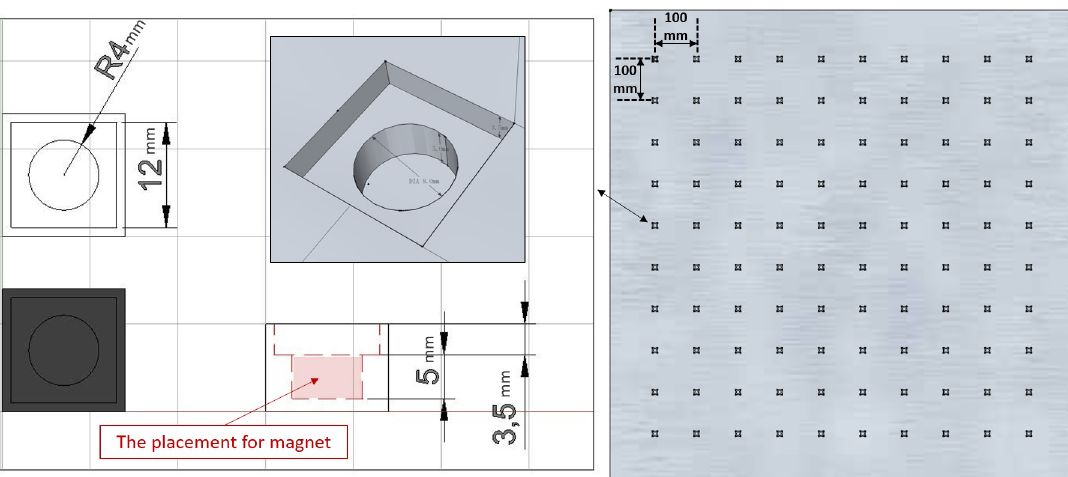
Fig 2. Sketch of the design for the alignment board. There are one hundred placements for the special reflective